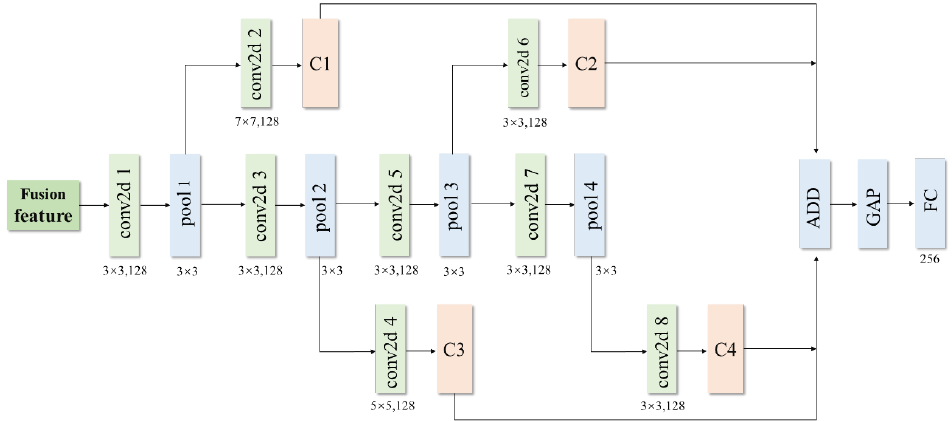
Figure 3. Multi-scale and multi-level feature extraction (MMFE) model. GAP: global average pooling; FC: fully connected layer.